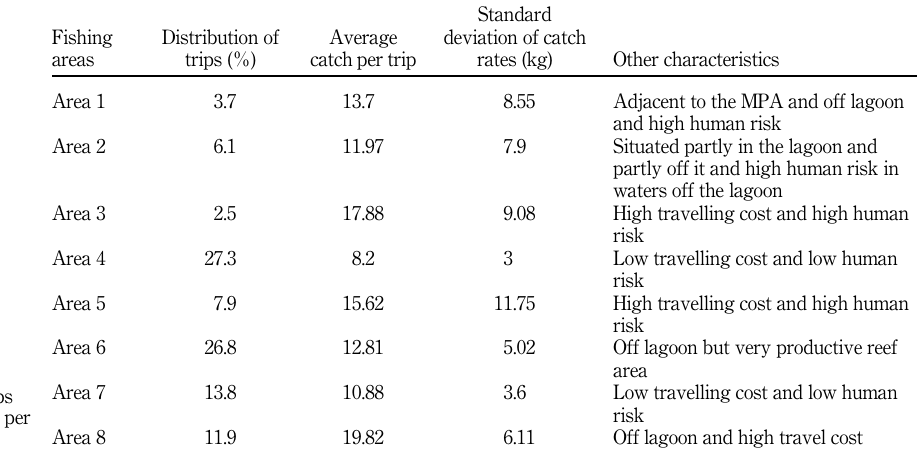
and average catch per trip from